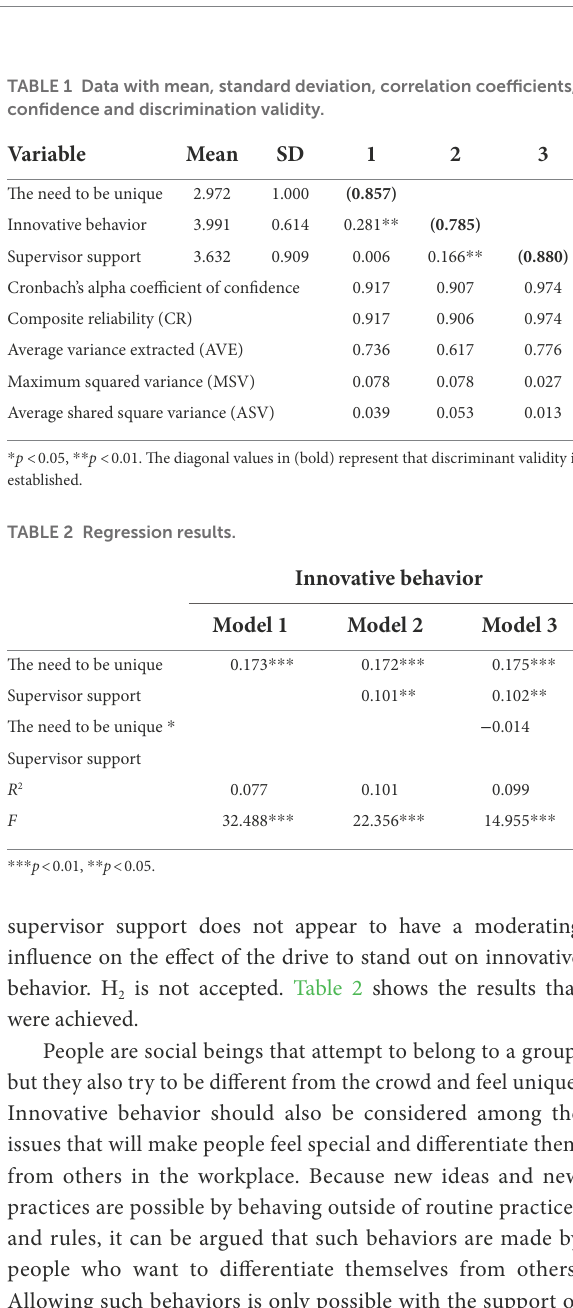
FIGURE 1 Research model.